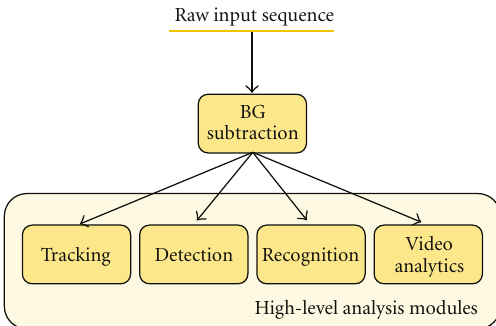
Figure 1: A typical video surveillance workflow: after background subtraction, several, higher-order, analysis procedures may be applied.